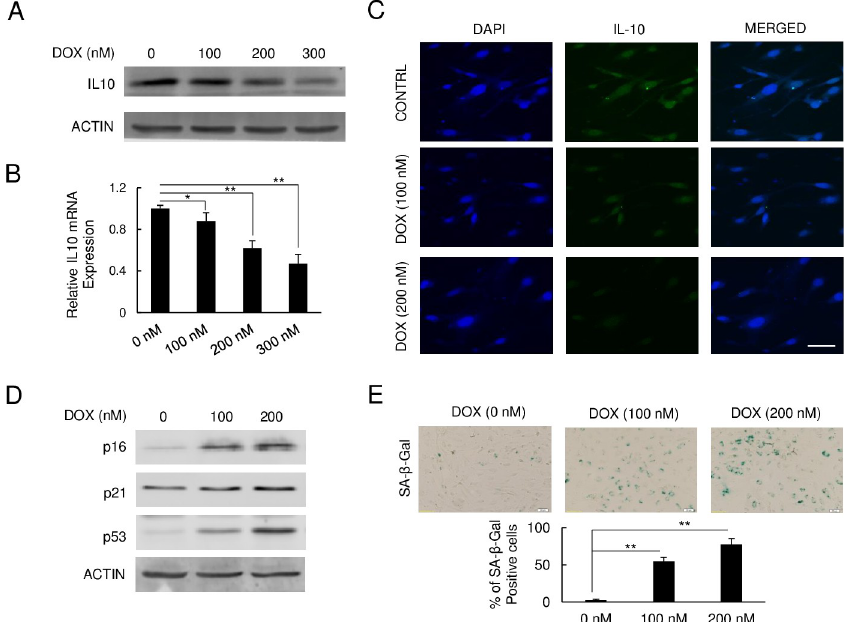
Fig 1. IL-10 levels decline in DOX-induced senescent HAECs. (A) Immunoblot of IL-10 after DOX treatment. (B) Relative IL-10 mRNA expression measured by qPCR ( � p < 0.05, �� p < 0.01, n = 3). (C) Fluorescence staining of IL-10 on HAEC cells. IL-10 was stained with FITC-labeled and DAPI was performed for nucleus staining. Scar bar, 10 μ m. (D) Immunoblot of senescence markers, p16, p21, and p53 expression levels on DOX treatment. (E) SA- β -Gal staining of senescent HAECs after DOX treatment. Senescent cells were stained with blue color under IPTG reaction ( �� p < 0.01, n = 5). Scar bar, 20 μ m.